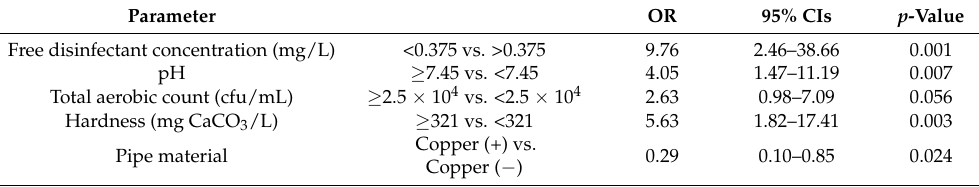
Table 5. Multivariate analysis for colonization of water supply systems with Legionella